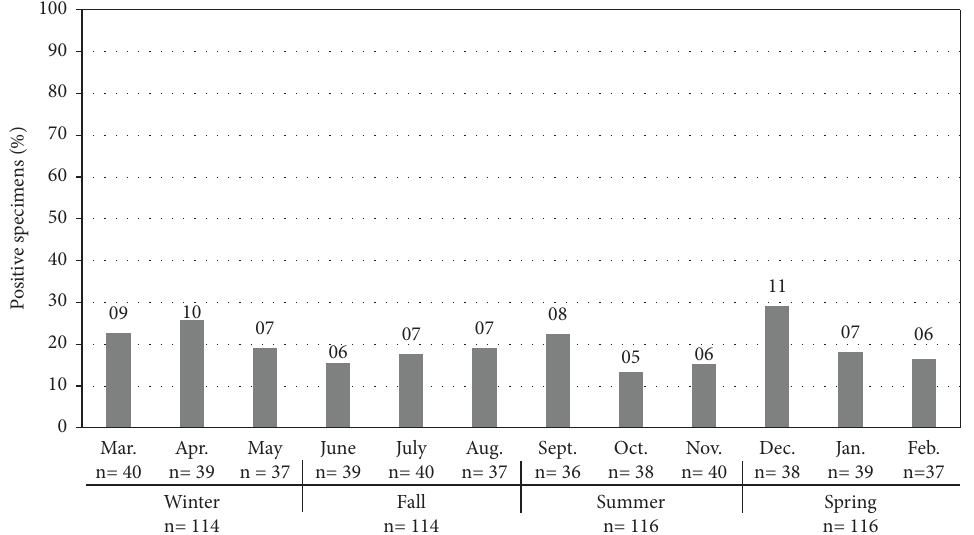
Figure 2: Seasonal and monthly rate of prevalence of H. pylori where number of positive specimens is shown above each bar.